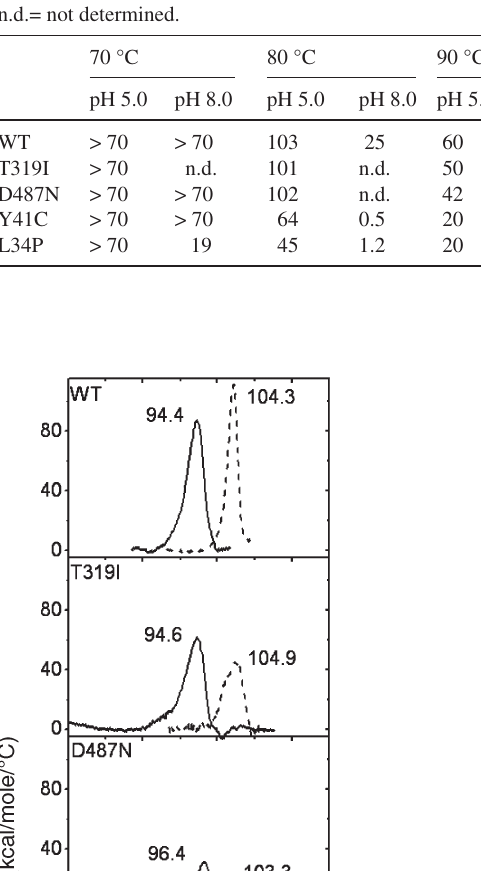
Table 4. Thermal stability (half-life, h) of the WT Sulfolobus solfataricus recombinant amidase and its mutants. Incubations were conducted at the reported temperatures in Eppendorf tubes (0.2 ml) containing0.2 mg ml –1 proteinin 70 µl of 50 mMcitratebufferpH 5.0 or sodium phosphate buffer pH 8.0 . After incubation, a 50 µl sample was assayed for standard activity at pH 5.0 and 70 °C. Abbreviation: